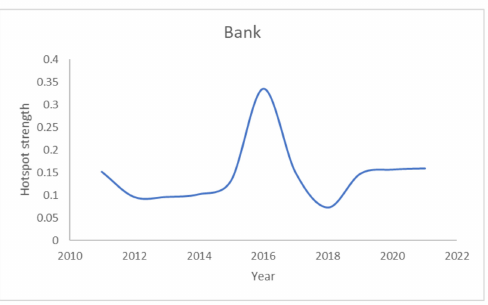
Figure 8. Trend of the hot spot strength for drug crimes in the Bank cluster.